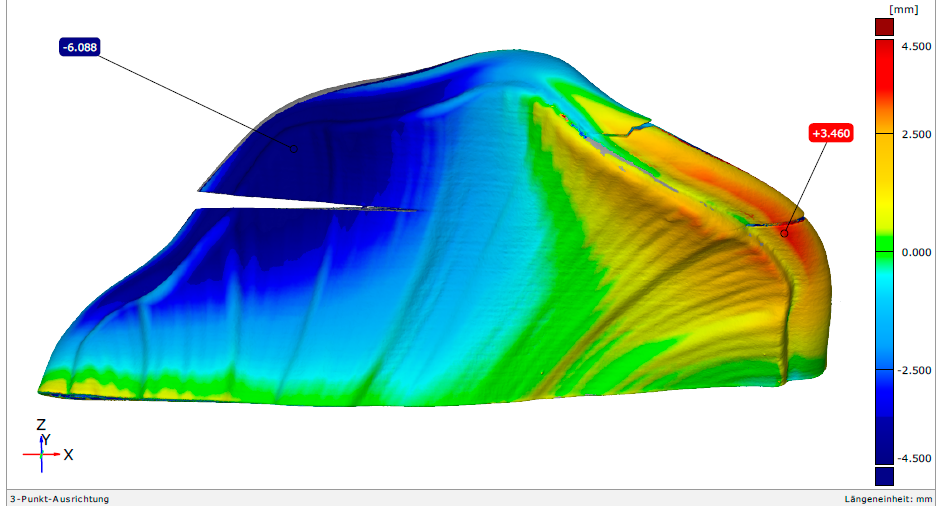
Figure 16. Superimposed fragment 1: manufacturing direction: clockwise; sintered.